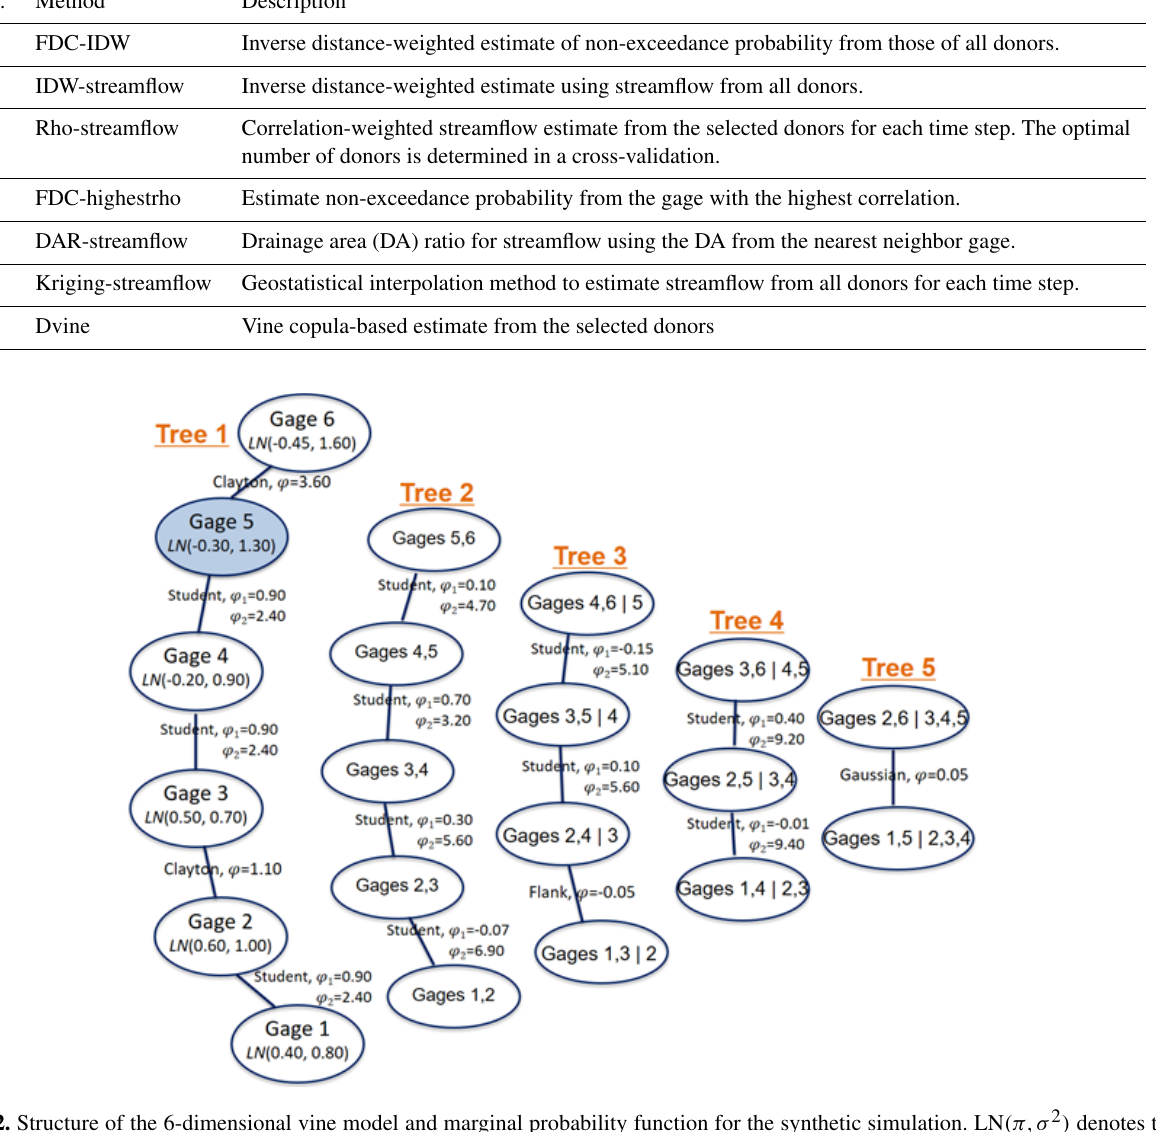
Figure 2. Structure of the 6-dimensional vine model and marginal probability function for the synthetic simulation. LN (π,σ 2 ) denotes the log normal distribution with its mean ( π ) and variance ( σ 2 ). The target gage is